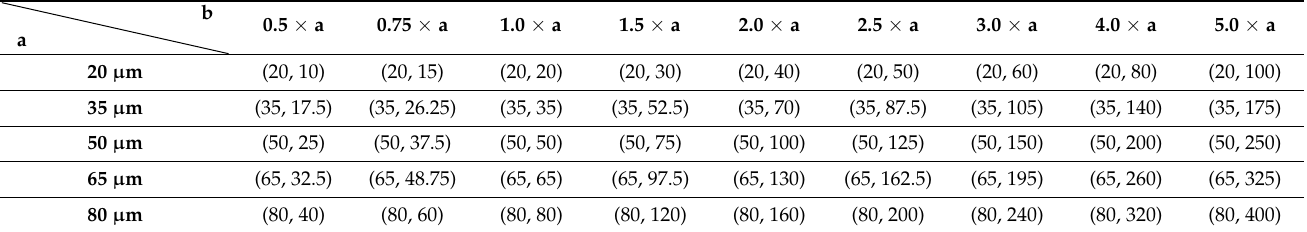
Table 1. List of the combinations of ( a , b ) geometrical parameters used in the simulations. All dimensions are listed in micrometers [ µ m].